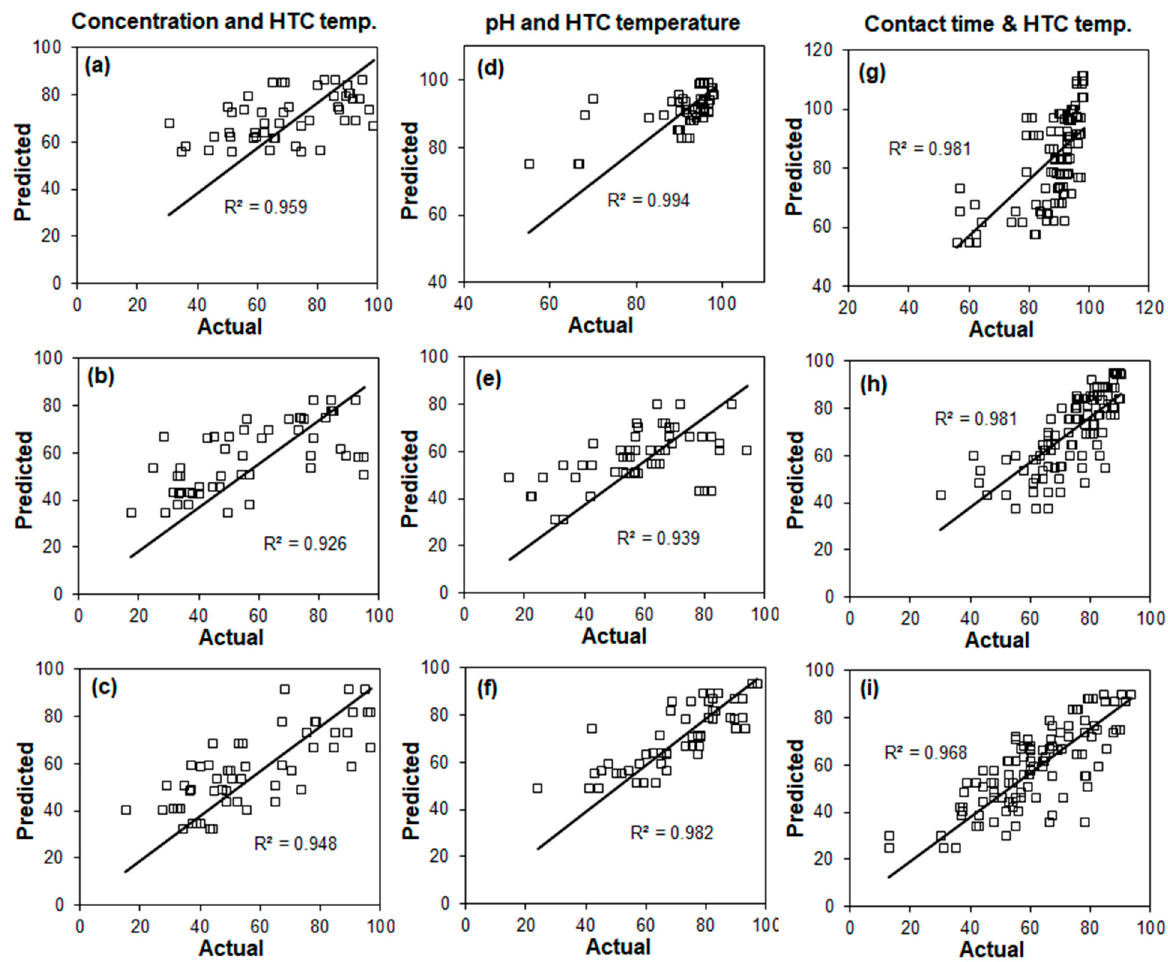
Figure 8. Predicted vs. actual results of percentage dye removal for: concentration and HTC temperature modelling; ( a ) FS hydrochars, ( b ) CS hydrochars, ( c ) Oak hydrochars. pH and HTC temperature modelling; ( d ) FS hydrochars, ( e ) CS hydrochars, ( f ) Oak hydrochars. Contact time and HTC temperature modelling; ( g ) FS hydrochars, ( h ) CS hydrochars, ( i ) Oak hydrochars.